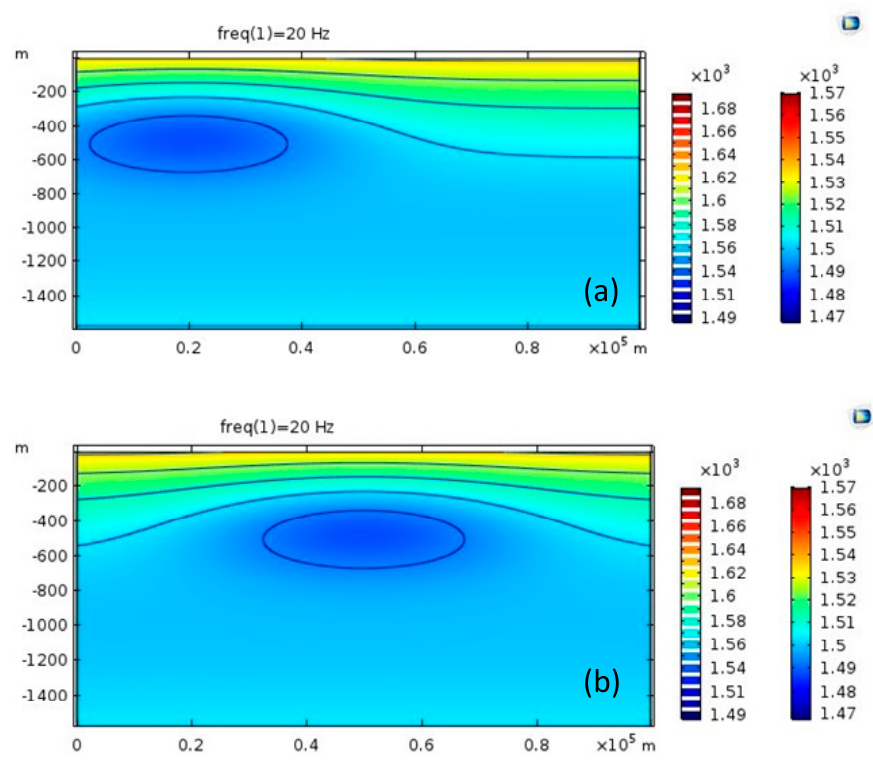
Figure 14. The sound velocity distribution of the cold vortex at different positions in the sound field, ( a ) Rx = 20,000 m, DC = − 20 m/s, ( b ) Rx = 50,000 m, DC = − 20